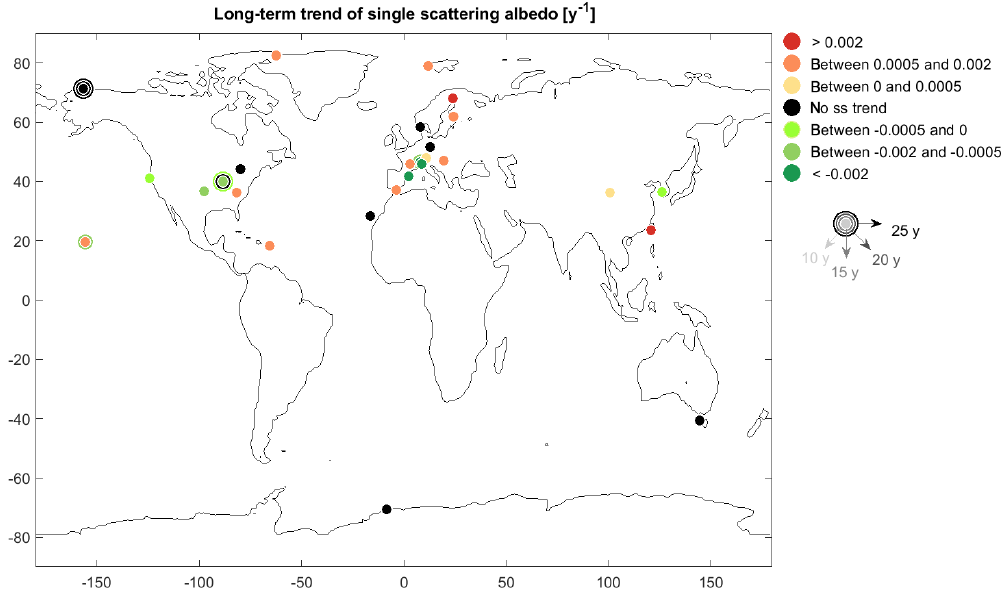
Figure 7. MK trend results for the single scattering albedo. Other details same as Fig. 4.